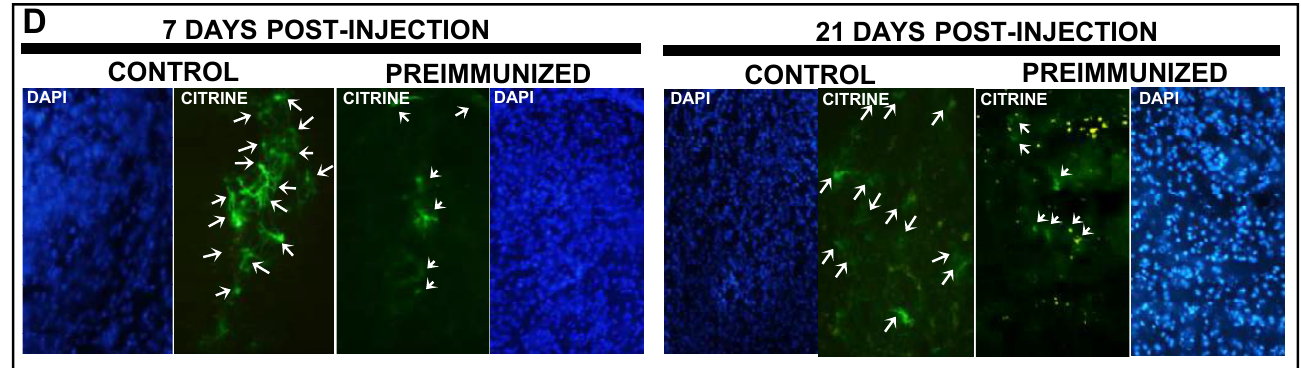
Figure 7. BV-mediated transgene expression stability in the brain of preimmunized mice. ( A ) C57Bl/6